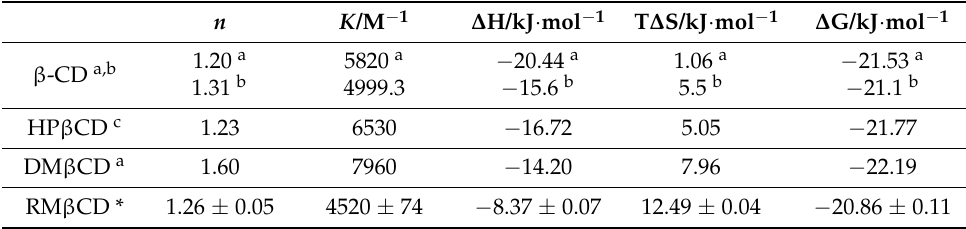
Table 1. Stoichiometry coefficients of binding (n), binding constants (K), enthalpic ( ∆ H), and entropic (T ∆ S) contributions into the Gibbs free energies values ( ∆ G) during the complex formation of sertraline hydrochloride molecules with some β -cyclodextrin derivatives at T = 298.15 K under atmospheric pressure p = 101,800 Pa obtained by ITC. n K /M − 1